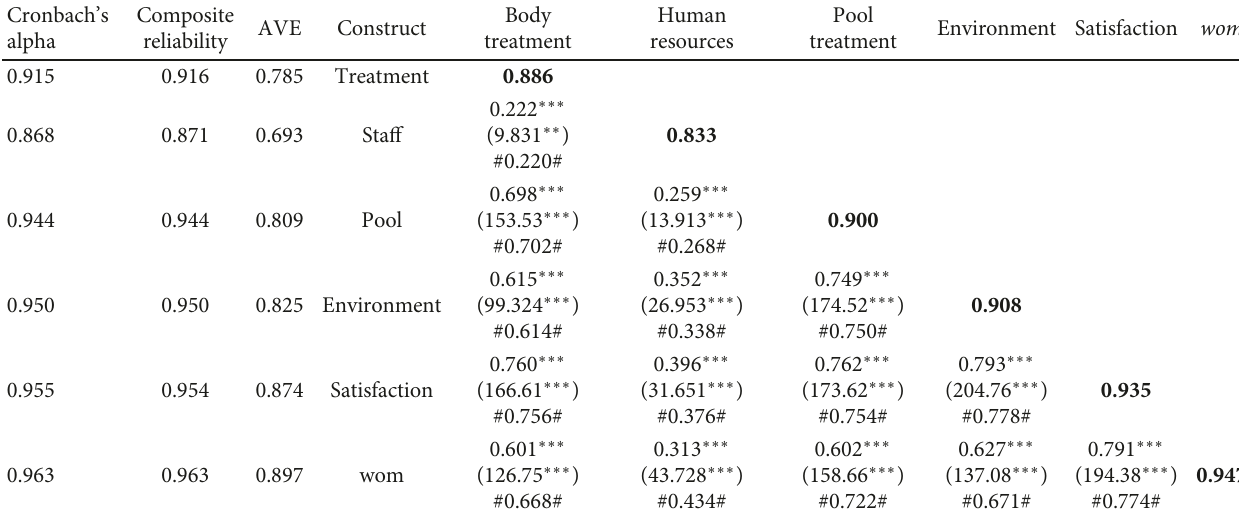
Table 2: Reliability, convergent validity, and discriminant validity: correlation coe ffi cients and chi-square di ff erence test. Cronbach ’